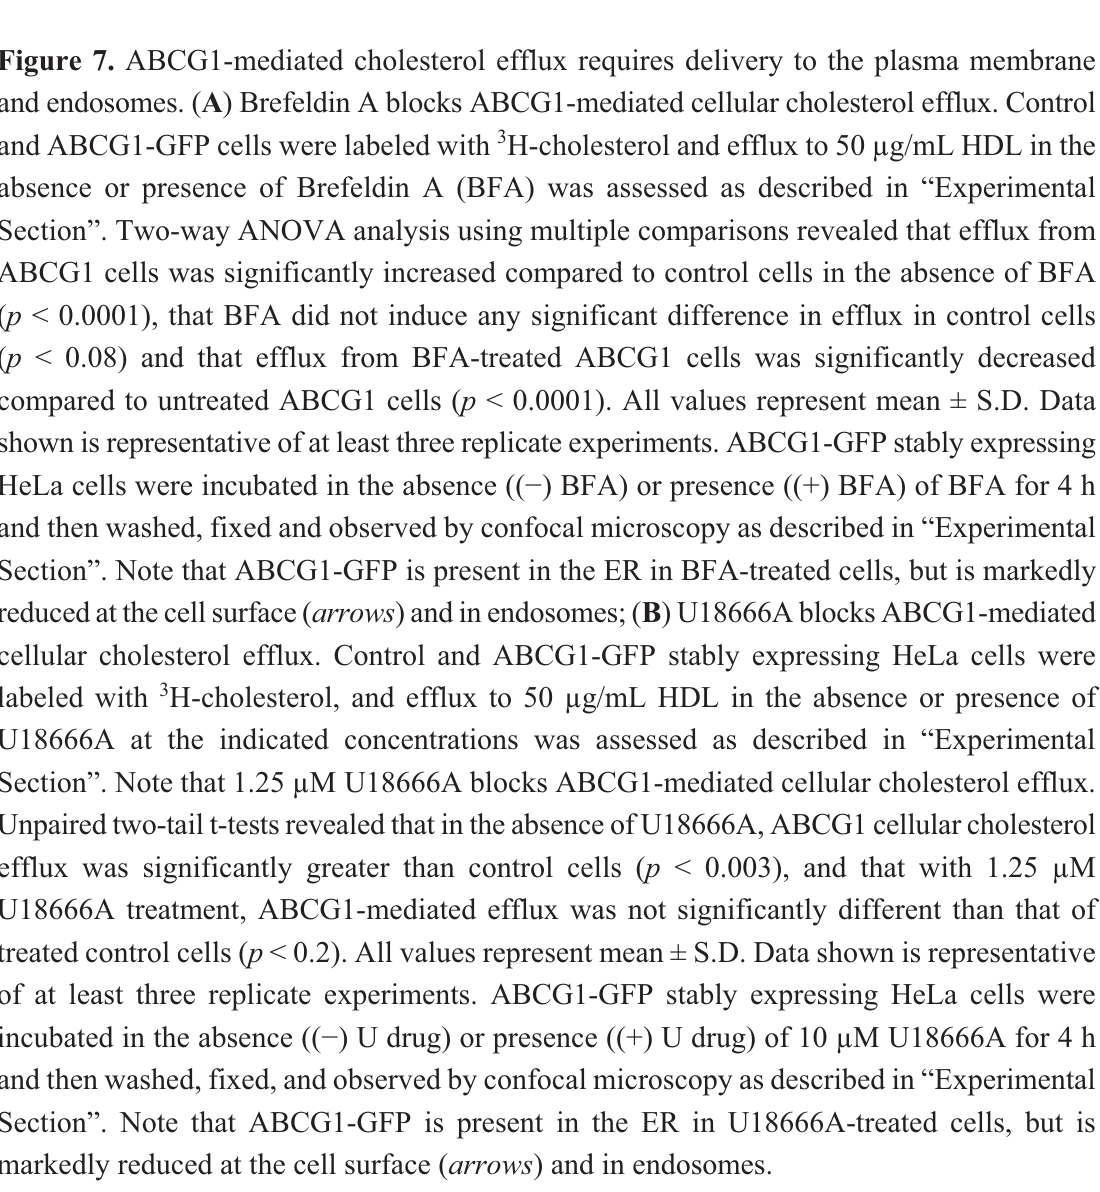
Figure 7. ABCG1-mediated cholesterol efflux requires delivery to the plasma membrane and endosomes. ( A ) Brefeldin A blocks ABCG1-mediated cellular cholesterol efflux. Control and ABCG1-GFP cells were labeled with 3 H-cholesterol and efflux to 50 μg/mL HDL in